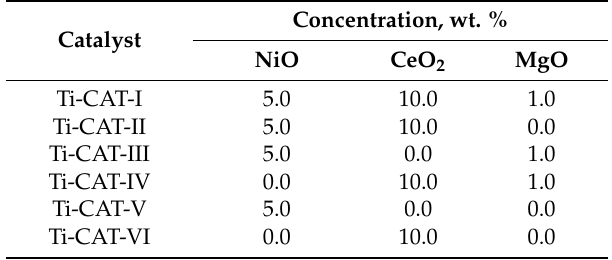
Table 4. Prepared catalyst samples and the wt. % of their